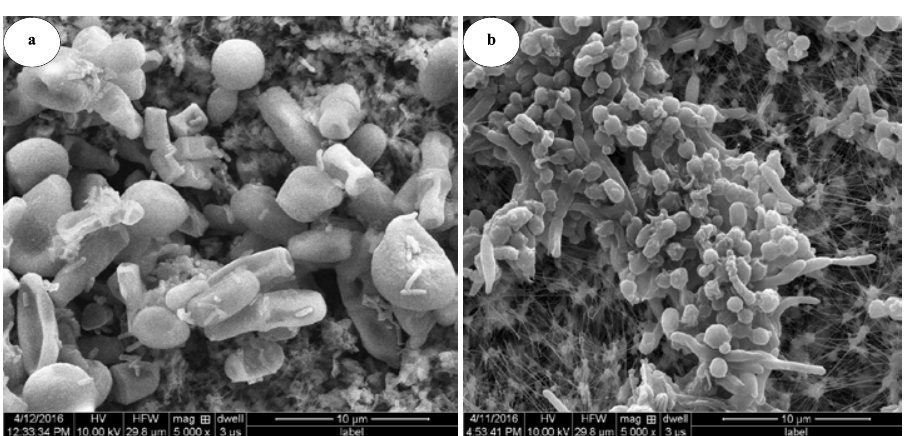
Fig. 4. Morphological view of bacterial strains observed under scanning electron microscopy analysis during bioaugumentation process at 5000x magnification